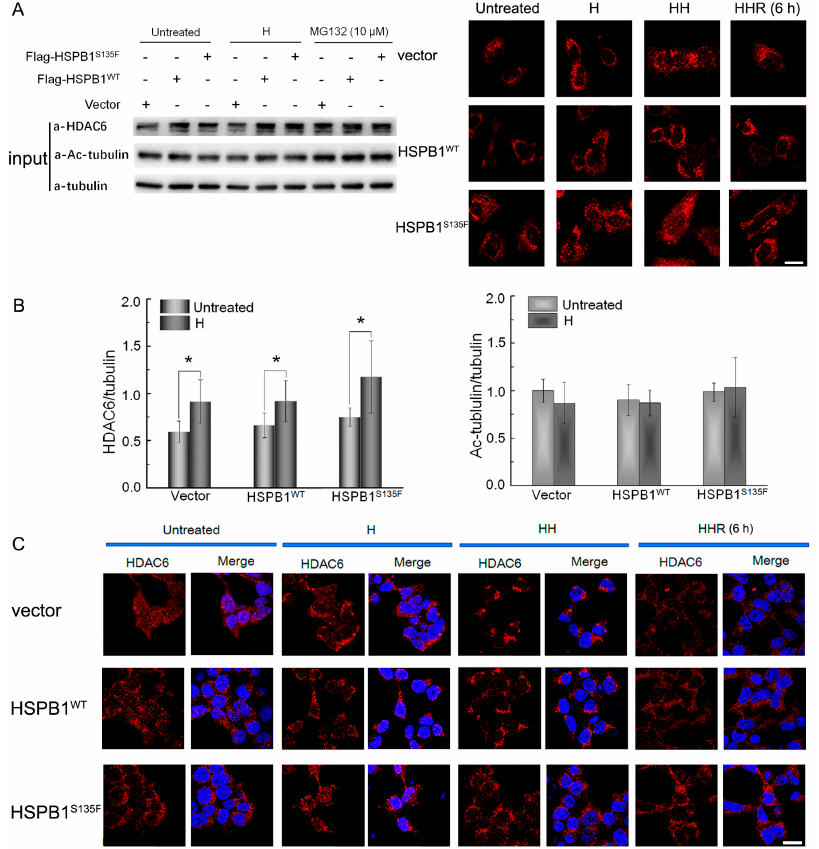
Figure 3. HSPB1 S135F prevents perinuclear translocation of HDAC6. ( A ) Western blot of HEK293T cells treated with repeated heat shock or MG132. ( B ) Quantification of HDAC6 and acetylation level of tubulin; * , p < 0.05 versus respective untreated group. Intracellular distribution of HDAC6 (red) was investigated by immunofluorescence staining of HEK293T cells ( C ) and SH-SY5Y cells ( D ). Upon repeated heat shock, HDAC6 was found to agglomerate into punctate or linear aggregates in cells with vector and HSPB1 WT while into large diffused aggregates in cells with HSPB1 S135F . Scale bars: 20 µ